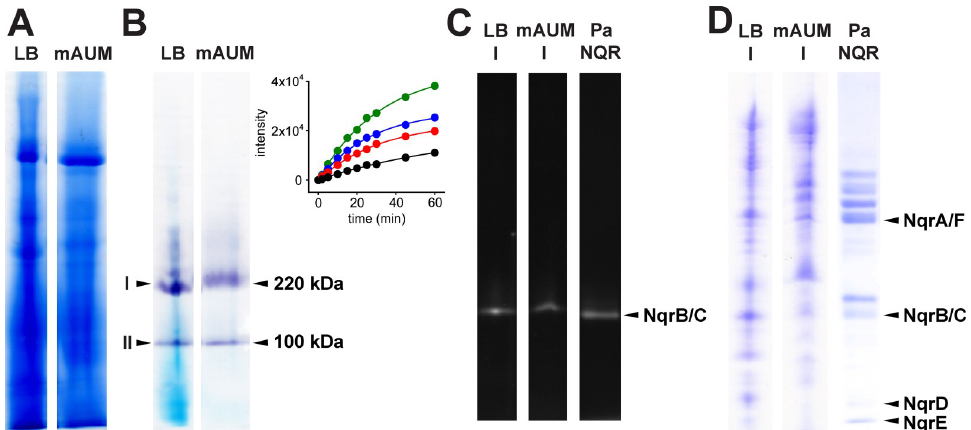
Fig 5. BN and 2D-SDS PAGE identification of NQR in LB and mAUM membranes. A) Coomassie-stained BN-PAGE gel of lanes containing solubilized LB and mAUM membranes. B) In-gel NADH dehydrogenase activity of BN-PAGE lanes of LB and AUM membranes, showing the 100 and 220 kDa bands. Inset, densitometry assay of the in-gel kinetics of NADH dehydrogenase activity (Black, LB -100 kDa; Red, AUM-100 kDa; Blue, LB-220 kDa; Green, AUM-220 kDa). The 220 kDa bands of the BN-PAGE gel were excised and run in a second dimension SDS-PAGE. The 2D gel lanes were exposed to UV light to identify the fluorescent bands of NQR subunits B and C (panel C), which co-migrate in this type of gel, due to the high hydrophobicity of subunit B, and were subsequently Coomassie-stained (D). Purified Pa-NQR [24] was run as standard for comparison.